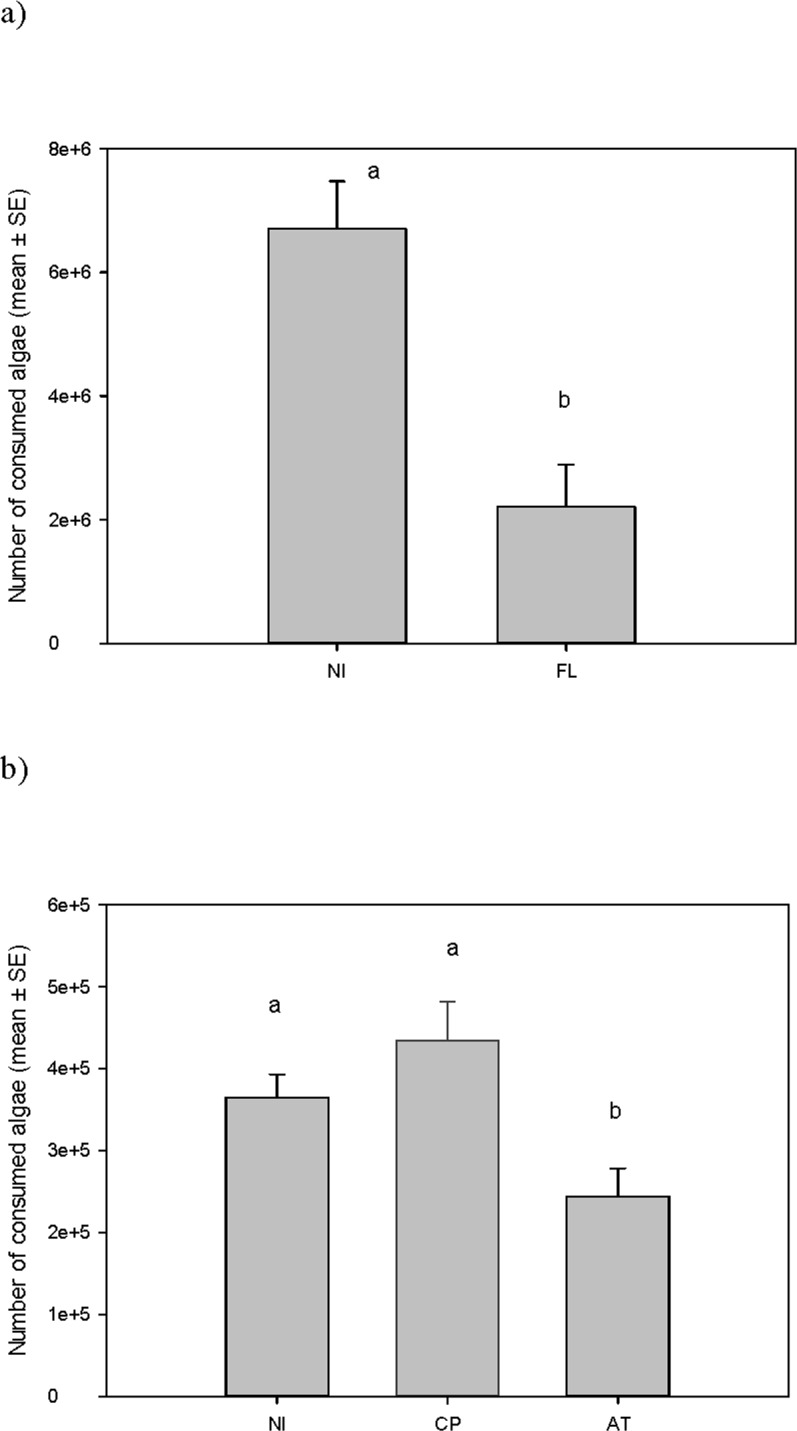
Feeding rate of infected and uninfected Artemia parthenogenetica.a) Feeding rate of non-infected (NI) and F. liguloides-infected (FL) Artemia. b) Feeding rate of non-infected Artemia (NI) and two categories of infected individuals (with Confluaria podicipina CP and Anomotaenia tringae AT). Statistically significant differences among treatments are indicated by letters above the bars (according to post hoc LSD tests). When treatments do not share a letter it indicates they are significantly different. Exact P values are shown in S4–S6 Tables.